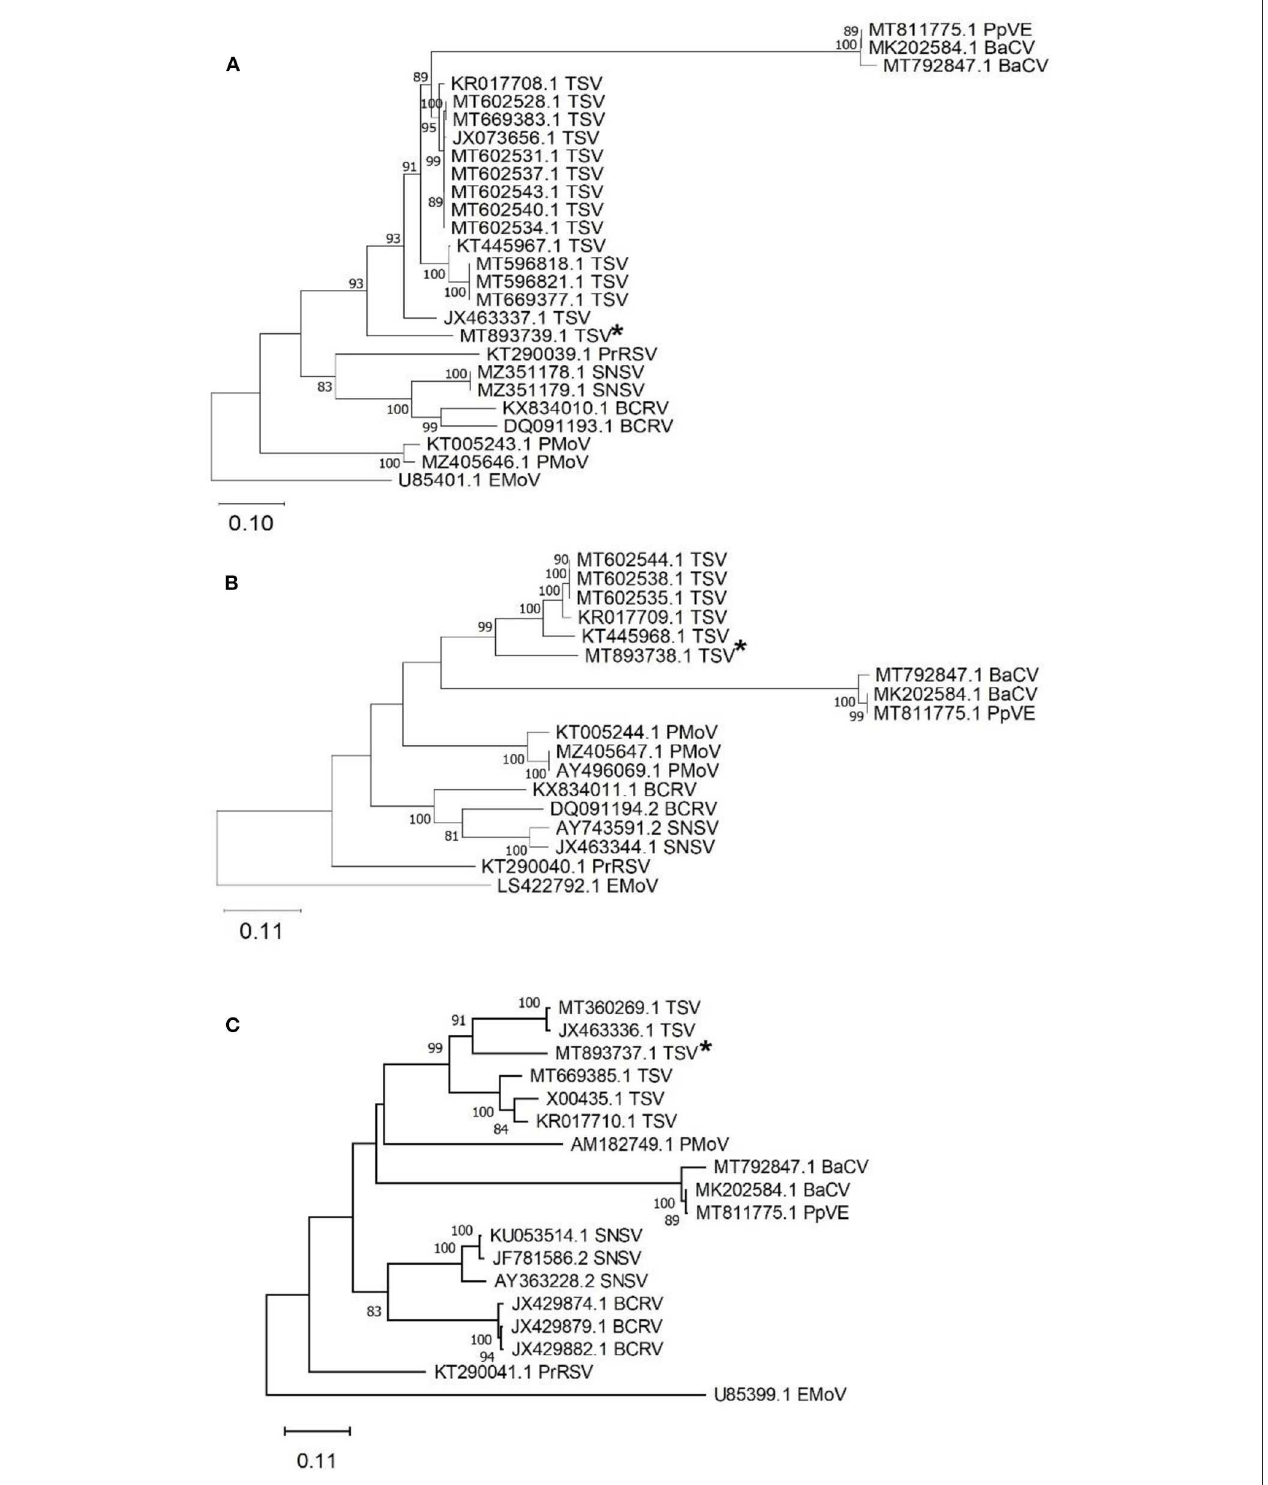
FIGURE 4 | Phylogenetic analysis of tobacco streak virus (TSV) RNA 1-3 obtained from hemp samples collected during the 2019 field season in Colorado and other TSV sequences available in GenBank. (A) TSV RNA 1 encodes the replicase protein gene with elm mottle virus (EMoV) as an outgroup, (B) TSV RNA 2 encodes RNA-dependent RNA polymerase gene with elm mottle virus (EMoV) as an outgroup, and (C) TSV RNA3 encodes the movement protein with parietaria mottle virus